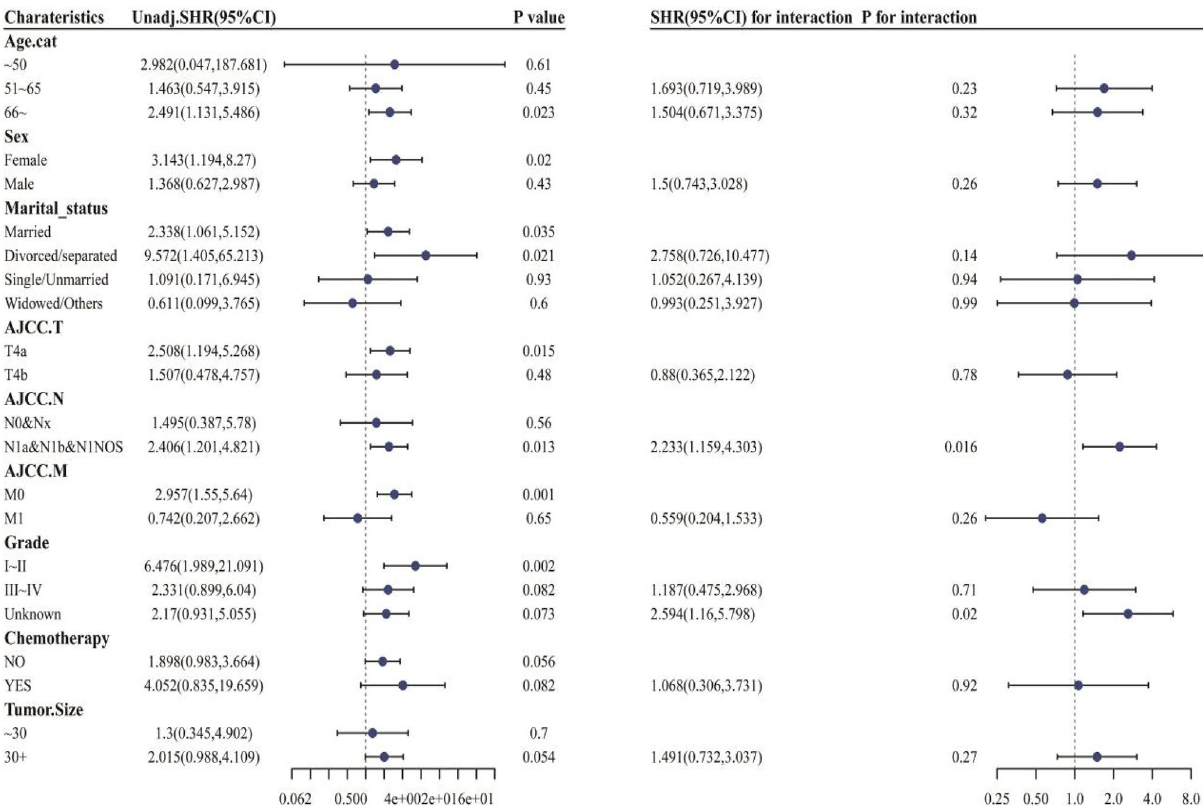
Figure 3. Subgroup analysis based on competitive risk model